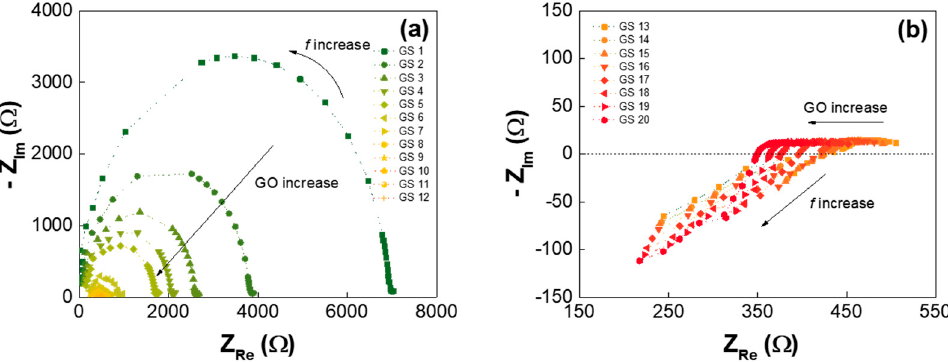
Figure 4. Nyquist plot of the GS samples: ( a ) for GS1 to GS11, which have low GO concentrations, and ( b ) for GS12 to GS20, which have high GO concentrations.